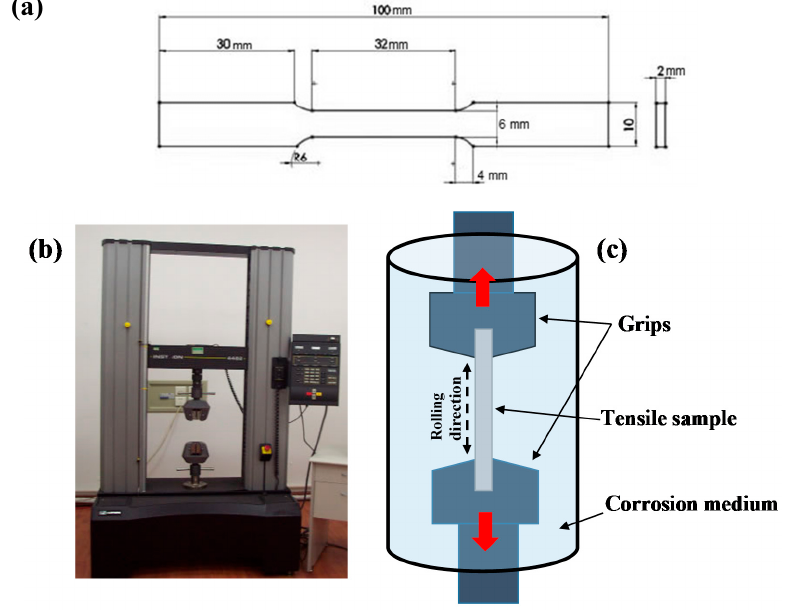
Figure 1. ( a ) ASTM E-8M tensile specimen; ( b ) Instron 4482 apparatus; and ( c ) schematic of stress corrosion setup.